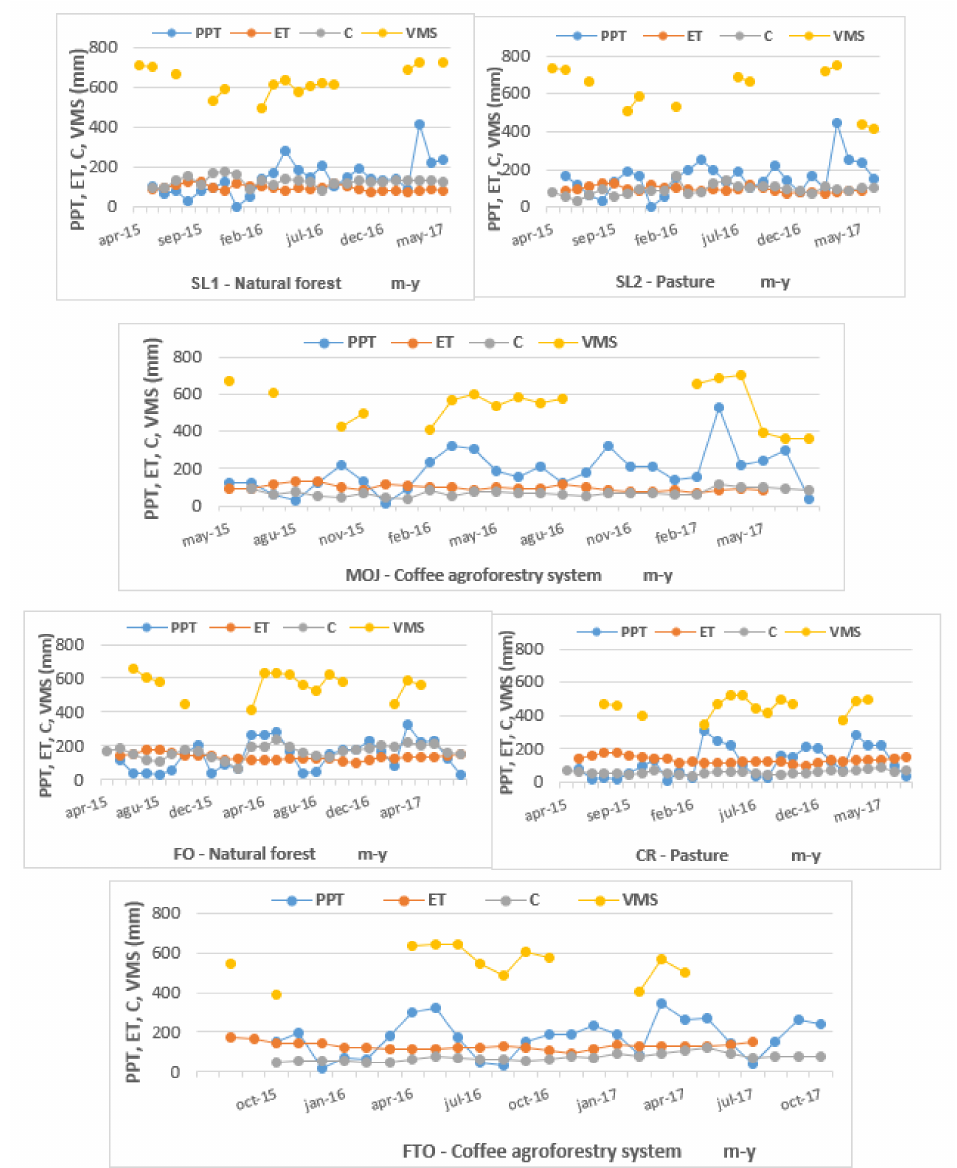
Figure 6. Water balance components distribution (BH) (April 2015–May 2017). Precipitation (P), evapotranspiration (ET), caudal (C), volumetric soil moisture (VMS) at the microbasin SL1, SL2, MOJ, Combeima River basin ( up ), and FO, CR, FTO, Cali River basin ( down